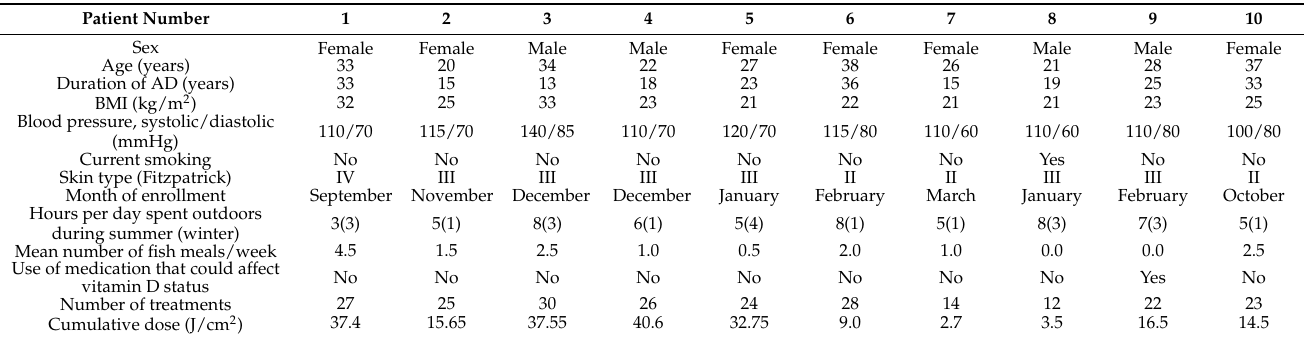
Table 1. Demographic data and confounding factors for vitamin D status in patients with atopic dermatitis (AD) treated with narrow-band UVB phototherapy.